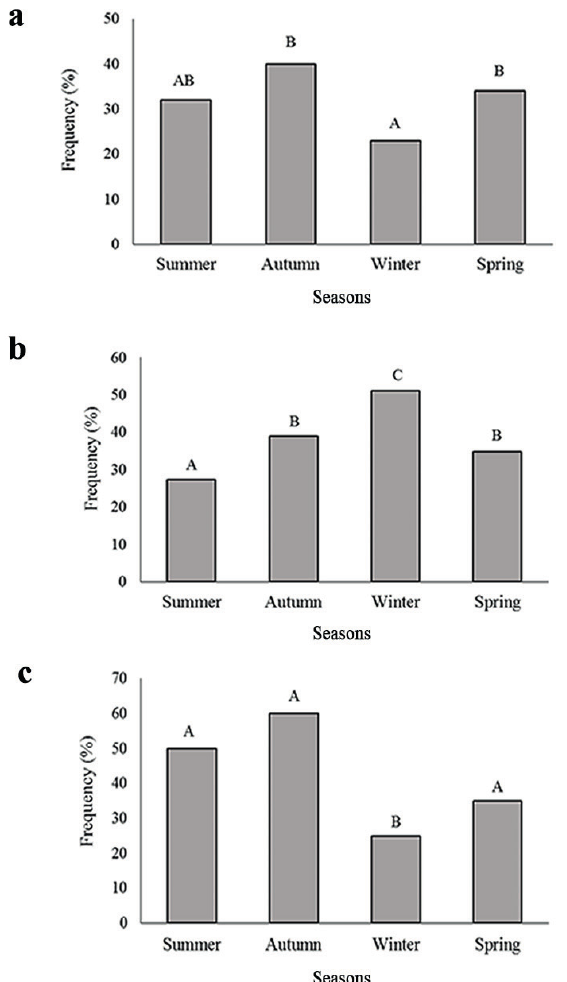
Figure 9 - Seasonal variation in the frequency of ovigerous females (%) of Hyalella pampeana in ( a ) site 1, ( b ) site 2 and ( c ) site 3. Values with at least one letter in common did not differ statistically